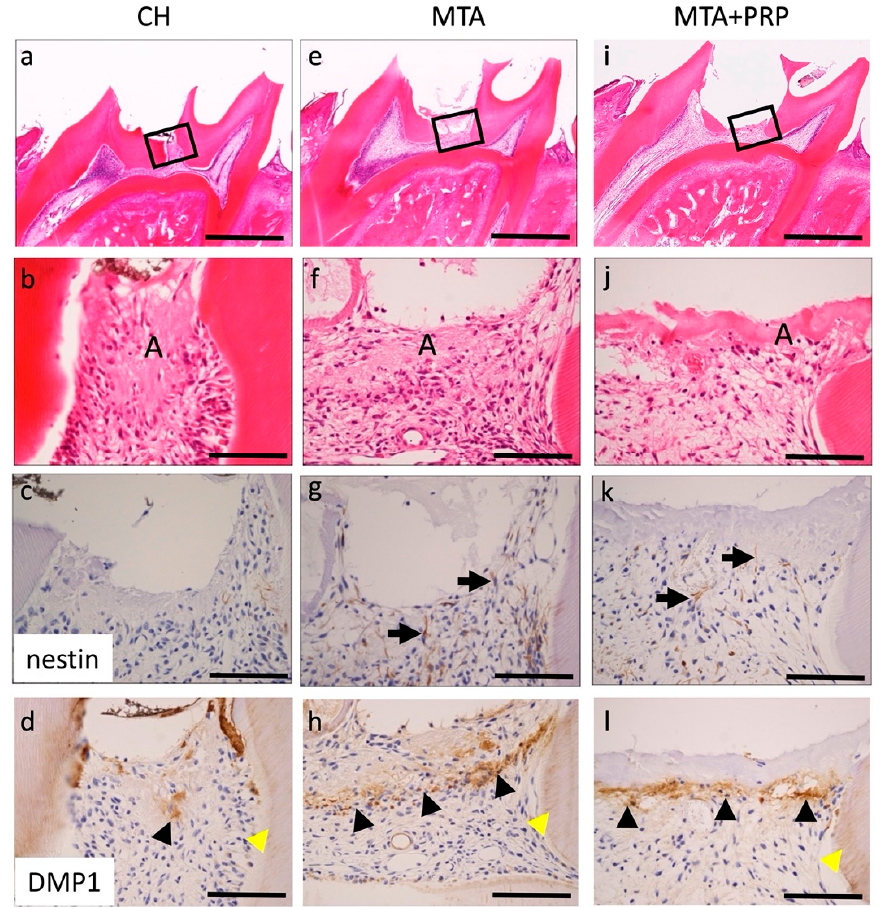
Figure 2. Histological findings of the pulp tissue at 3 days after pulp capping with CH ( a – d ), MTA ( e – h ), or MTA + PRP ( i – l ). Necrotic or amorphous layers ( A ) were observed at the exposure site of the dental pulp with relative inflammatory cell infiltration ( b , f , j ). Nestin was negative at the exposure site of CH ( c ). However, fibrillar and spindle-shaped cells were positive at the exposure site of MTA and MTA + PRP ( g , k , black arrows). DMP1 was localized in the dentinal tubes ( d , h , l , yellow arrowheads) and extracellular matrix beneath the necrotic/amorphous layers at the exposure site of CH, MTA, and MTA + PRP ( d , h , l , black arrowheads). Scale bars: 1 mm in ( a , e , i ); 100 µ m in ( b – d , f – h , j – l ). Table 1. Summary of the histological and immunohistochemical findings. After Pulp 3 Capping